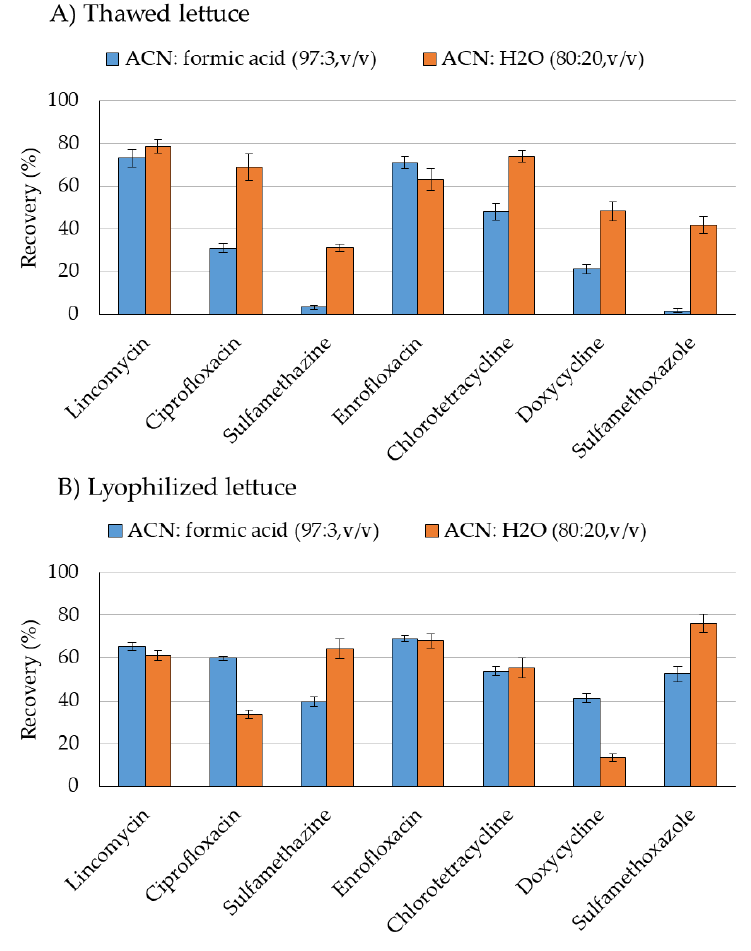
Figure 1. Influence of the extraction solvent on the recovery of 200 ng of each antibiotic spiked in ( A )